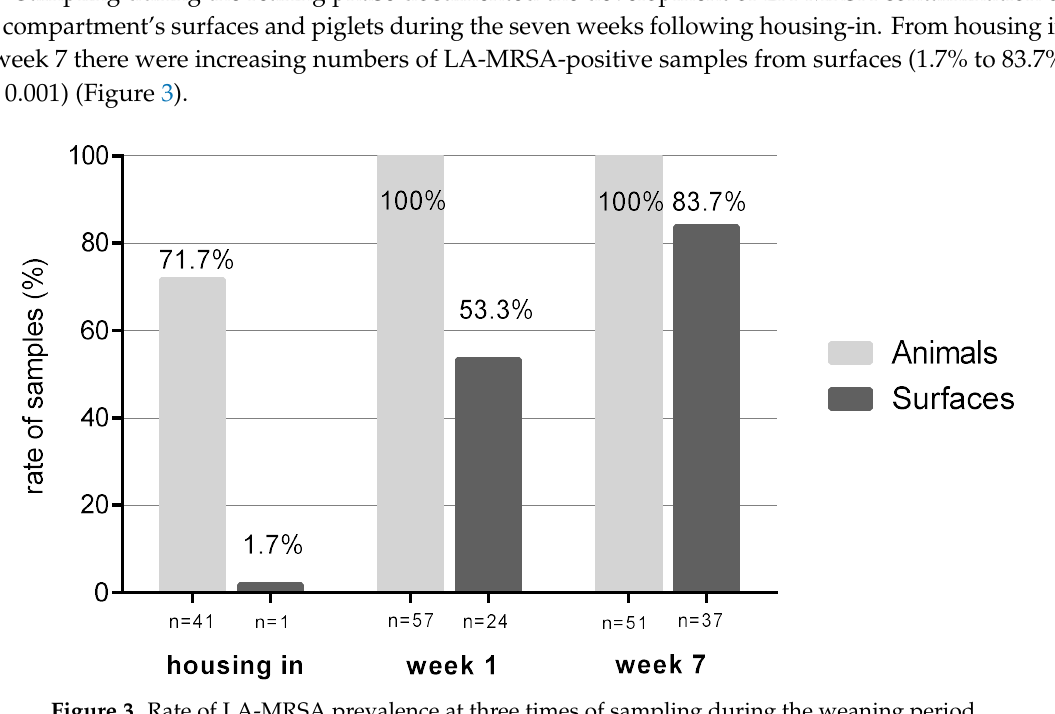
Figure 3. Rate of LA-MRSA prevalence at three times of sampling during the weaning